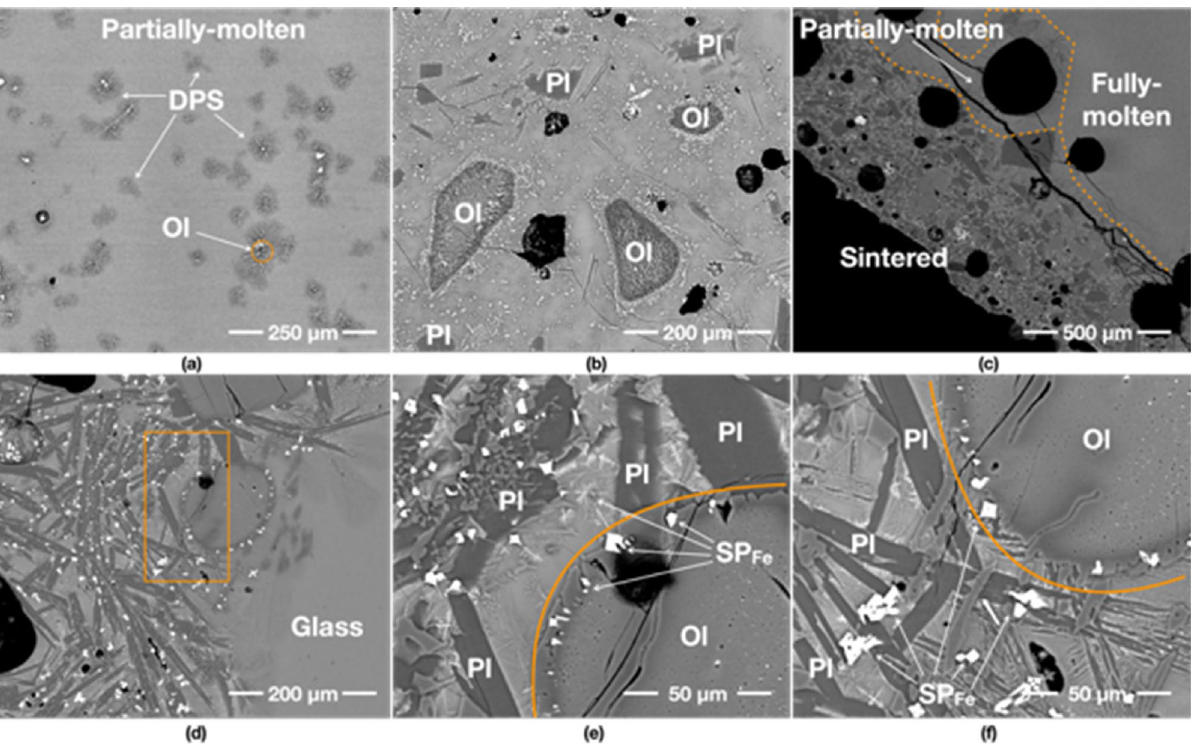
Figure 5. BSE images of 400 W specimen. ( a – c ) are an overview of its fully-molten, partially-molten and sintered areas. ( a ) Depicts many dendritic patterned silicate (DPS) formations in the partially-molten area. ( e , f ) are the details of the box in ( d ) showing large dendritic plagioclase (Pl) crystal growth and the formation of SP Fe particles from an olivine (Ol) grain. ( e , f ) also show the trace of SP Fe particle exsolution from the dark rim of an olivine (Ol) grain (see the dark rim near the orange